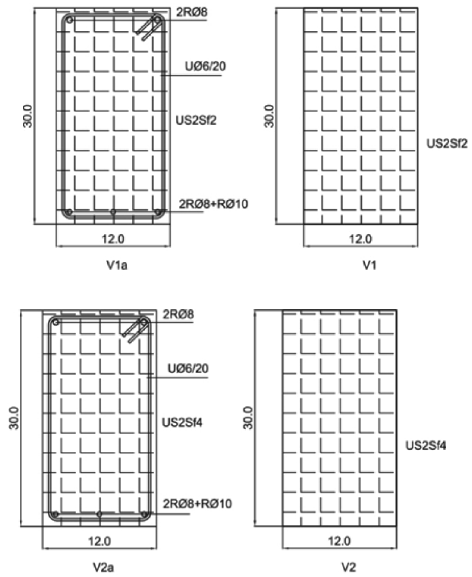
Fig. 9. Cross-section of tested beams